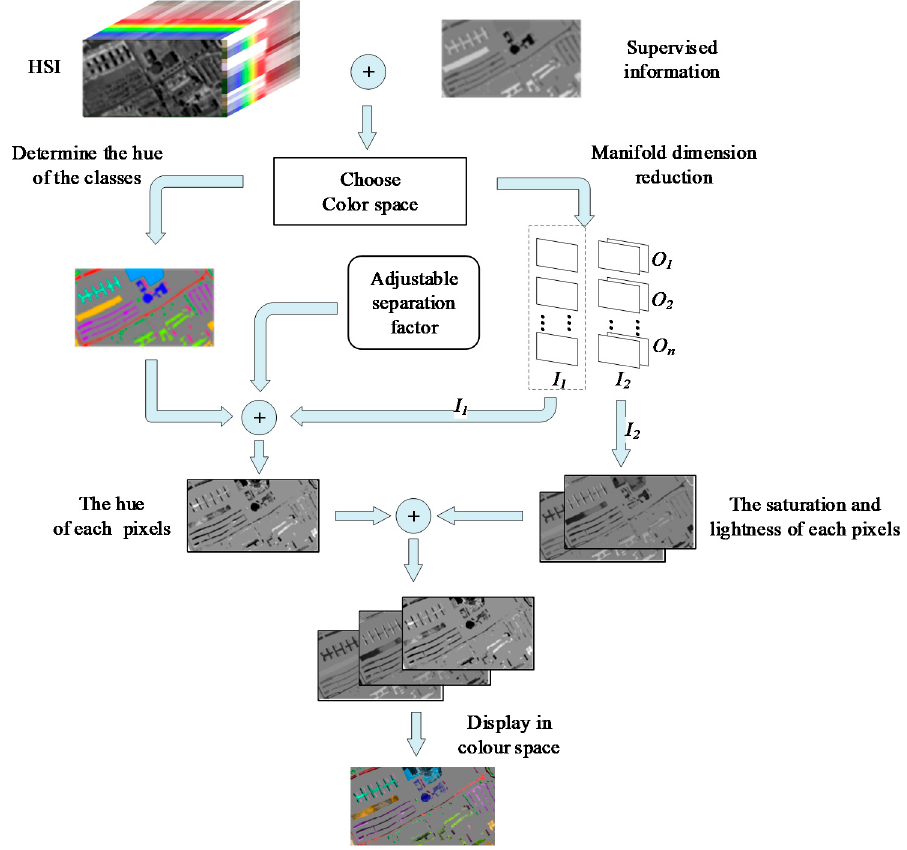
Figure 1. Flow diagram of the object-oriented visualization method of hyperspectral image (HSI).